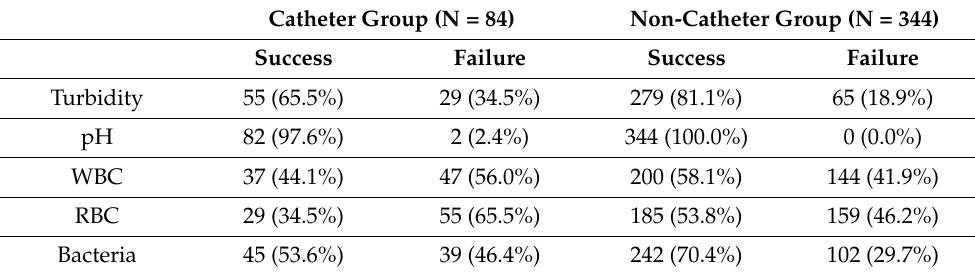
Table 4. The results of the urine test after treatment.